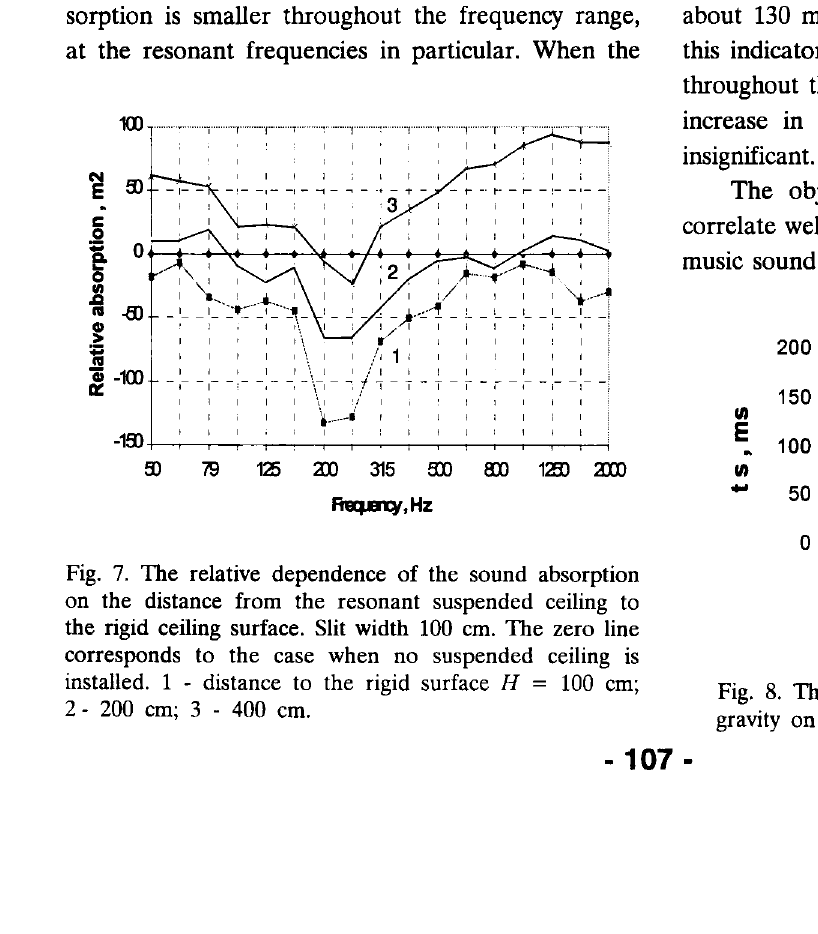
Fig. 8. The dependence of the acoustic centre of gravity on the height of the suspended ceiling